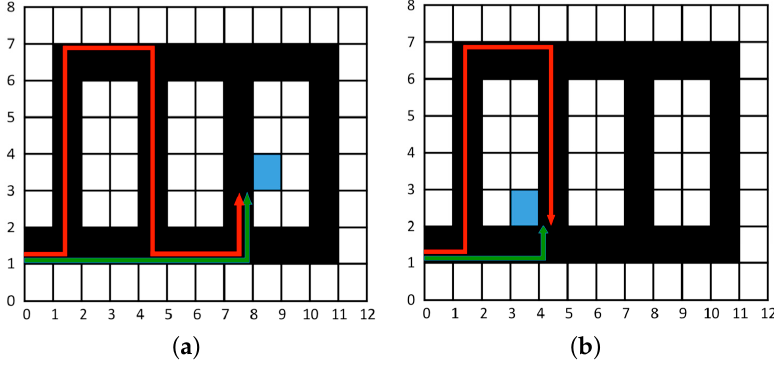
Figure 9. Efficient (green) and inefficient (red) routes to find an available parking space. ( a ) in ( 8,3 ) ; ( b ) in ( 4,2 )